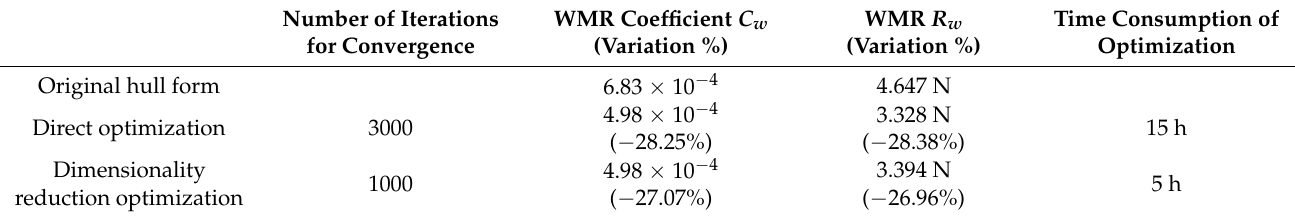
Table 12. Comparison of optimization results.